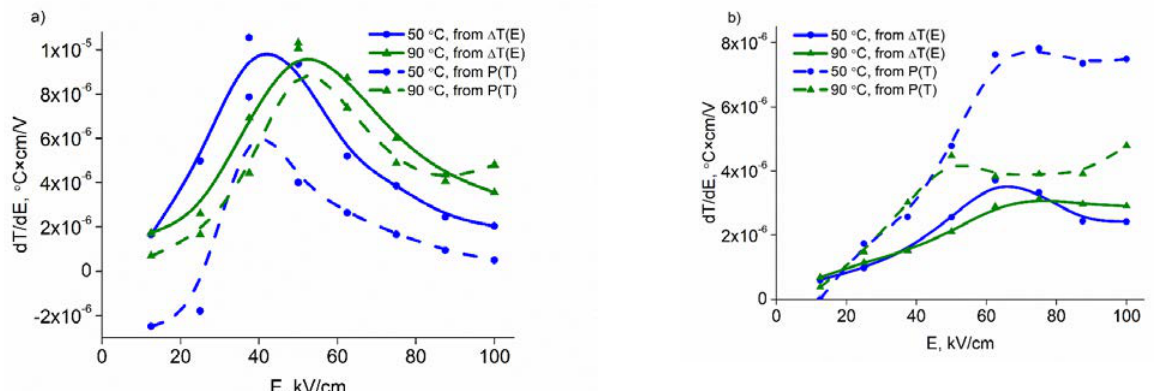
Figure 8. Comparison of dT/dE values obtained by the direct measurements of ∆ T(E) and extracted from P(T,E) according to Equation (3), using data from experimentally measured polarization current, for (1 − x)(0.8NBT-0.2BT) − xCT compositions with x = 0.100 ( a ) and x = 0.125 ( b ).